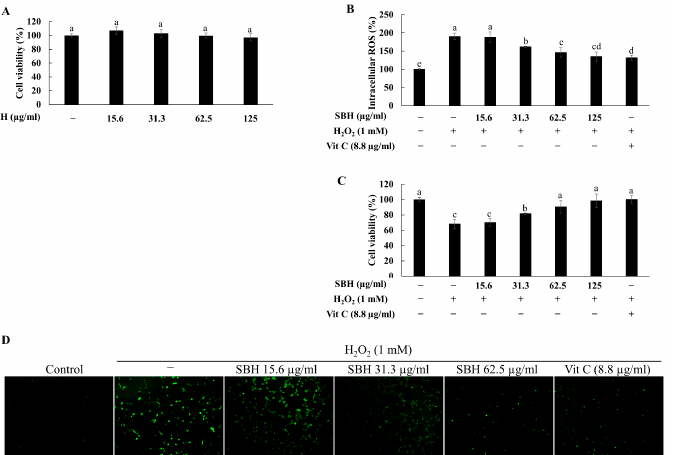
Figure 3. Cytocompatibility and protective effects of SBH against H 2 O 2 -induced oxidative stress in Vero cells. ( A ) Effects of SBH on Vero cell viability; Effects of SBH against H 2 O 2 -induced ( B ) intracellular ROS levels and ( C ) cell viability; ( D ) SBH’s effects on H 2 O 2 -induced intracellular ROS levels as studied by fluorescence microscopy. Experiments were carried out in triplicate and results were represented as means ± SD (n = 3). Means denoted by different letters are significantly different at p < 0.05. 3.5. SBH Lessens Mitochondrial Depolarization and Apoptosis in H 2 O 2 Stimulated Vero Cells Based on the antioxidant and cytoprotective effects observed for SBH, further testing was carried out to evaluate its anti-apoptotic effects in H 2 O 2 -stimulated Vero cells. JC-1 dye is commonly employed to assess mitochondrial health because of its potential-de- pendent accumulation in mitochondria. At low membrane potential, JC-1 produces green fluorescence whereas at high potential, the dye aggregates and produces red fluorescence [16]. As illustrated in Figure 4A, unhealthy mitochondria (lower red and higher green) were identified in the H 2 O 2 -treated cells. In the SBH-treated cells’ mitochondria, the mem- brane potential increased dose-dependently, as evidenced by a rise in the red and a re- duction in the green emissions. According to Figure 4B, the H 2 O 2 treatment increased the formation of apoptotic bodies as seen from nuclear condensation and fragmentation per Hoechst 33342 staining, as well as red color fluorescence per PI staining which are indic- ative of cells undergoing necrosis. Dose-dependent SBH treatment reduced apoptotic body formation. SBH dose of 62.5 µg/mL indicated comparable antiapoptotic activity with the positive control ascorbic acid at 50 µM. Cell cycle analysis was carried out to evaluate the proportion of Sub-G 1 hypodiploid cells. According to Figure 4C, the H 2 O 2 -treated group had 21.15% of cells under the Sub-G 1 phase compared to the control (1.62%). Dose- dependent treatment of SBH reduced the proportion of the Sub-G 1 cells. At an SBH dose of 62.5 µg/mL, the proportion of Sub-G 1 cells was 6.30%. The positive control ascorbic acid at 50 µM indicated a Sub-G 1 cell population of 3.35%.